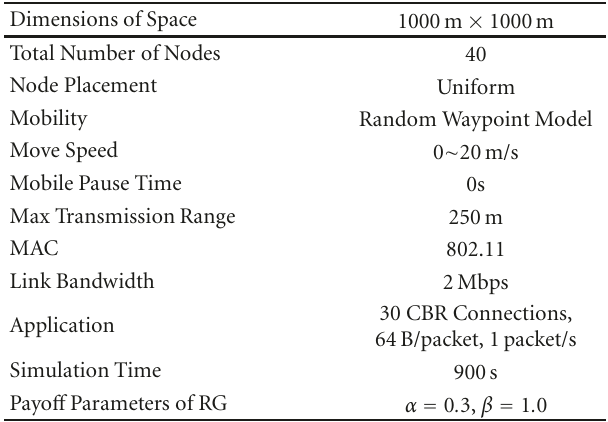
Table 3: Simulator parameters Table 4: The comparison of ratio of packet